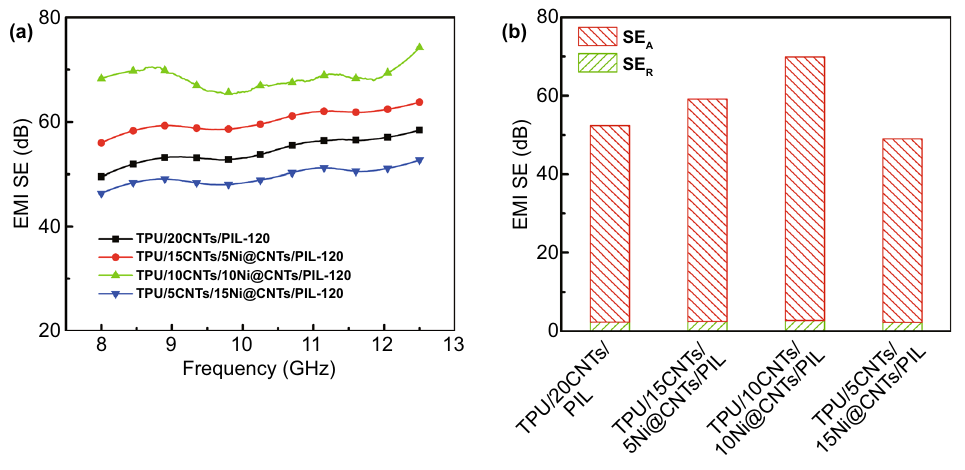
Fig. 7 a EMI SE of TPU/CNTs/Ni@CNTs/PIL foams; b comparison of SE T , SE A and SE R of TPU/CNTs/Ni@CNTs/PIL foams with 120 min evaporate time and various concentrations at 9.0